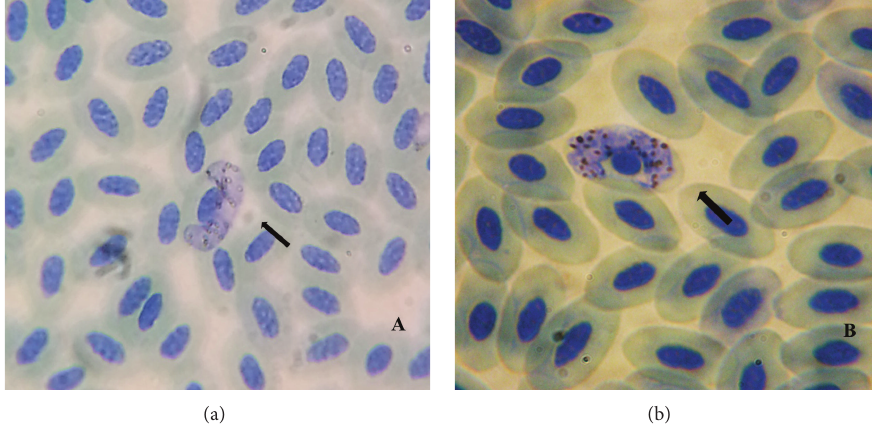
Figure 2: (a) Macrogametocyte of H. plataleae. (b) Macrogametocyte of H.